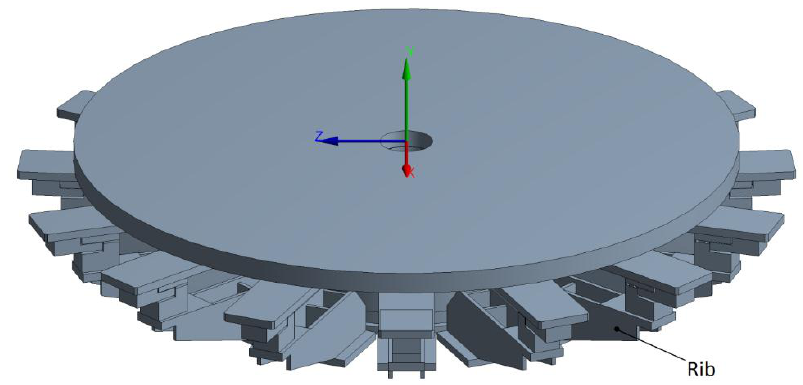
Figure 14. Transfer Machine with 15 divisions: a rib under each support helps increase its stiffness.